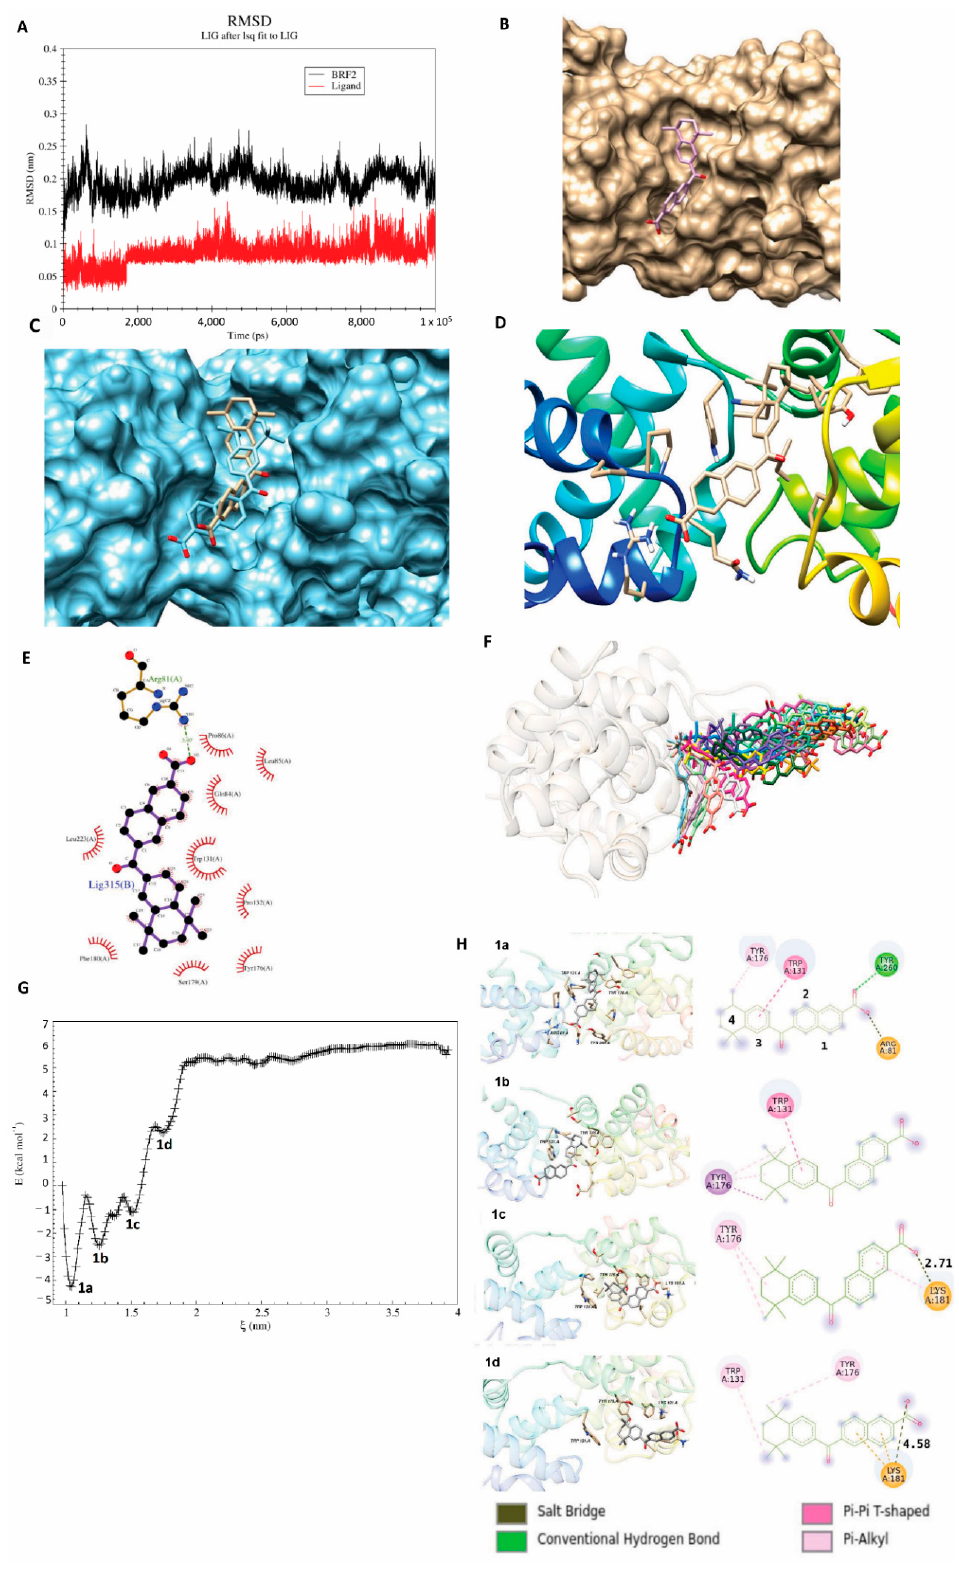
Figure 6. Molecular dynamic simulation. ( A ) RMSD of BRF2 (black) and the ligand (red) during the 100-ns MD simulation. ( B – D ) Docked BRF2-ligand complex presented in different views. ( B ) Surface view, ( C ), surface view showing the confor- mational changes of the ligand before (khaki) and after (blue) MD in the pocket, ( D ) ribbon view. ( E ) LigPlot-generated snapshot of the ligand and residues in the active site. ( F ) the unbinding pathway of the ligand from the binding site. ( G ) The PMF graph obtained from US simulation, ( H ) 1a, 1b, 1c, and 1d are the energy minima obtained through the US